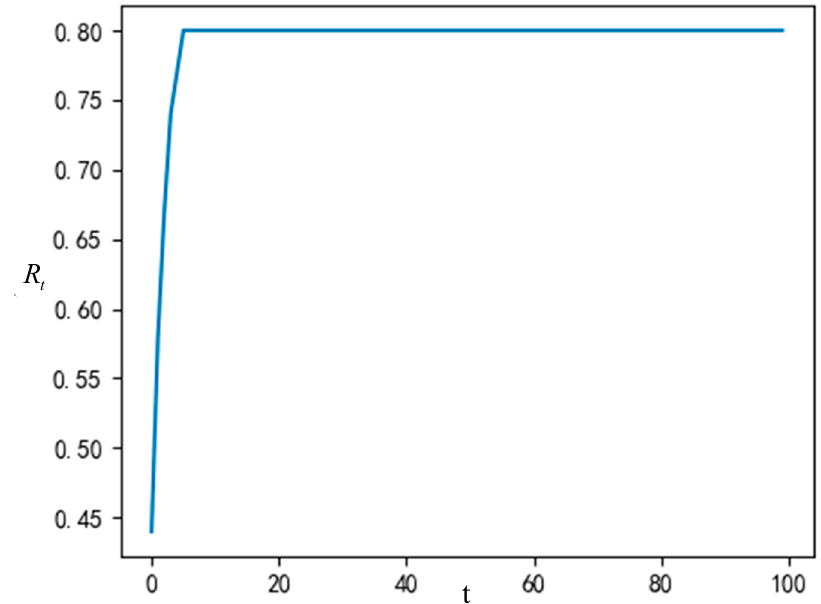
Figure 4. The proportion of nodes accepting innovation.